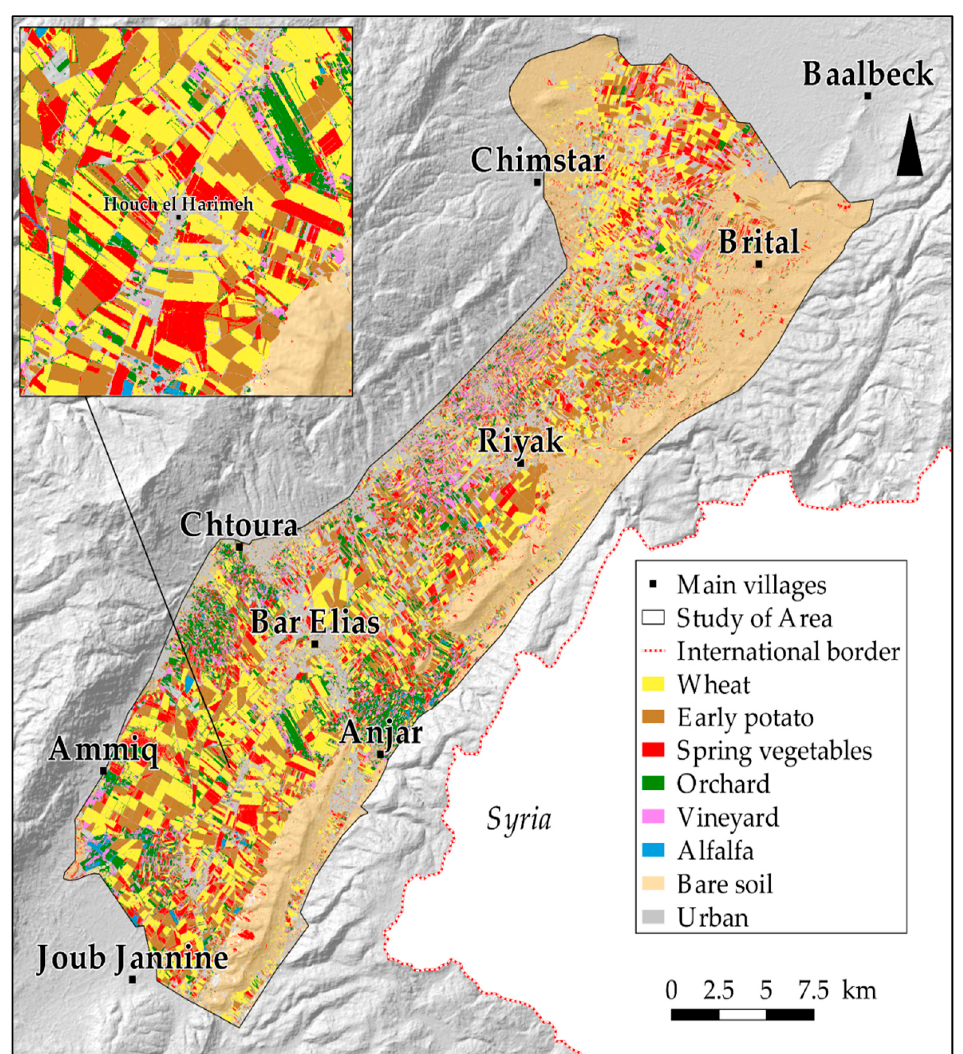
Figure 8. Crop map of the Bekaa Valley in spring 2017.